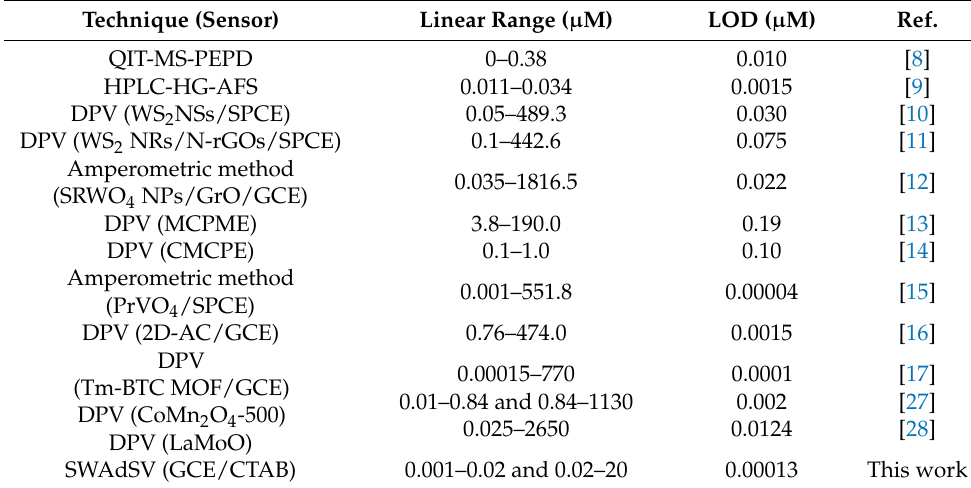
Table 1. Comparison of techniques used for ROX